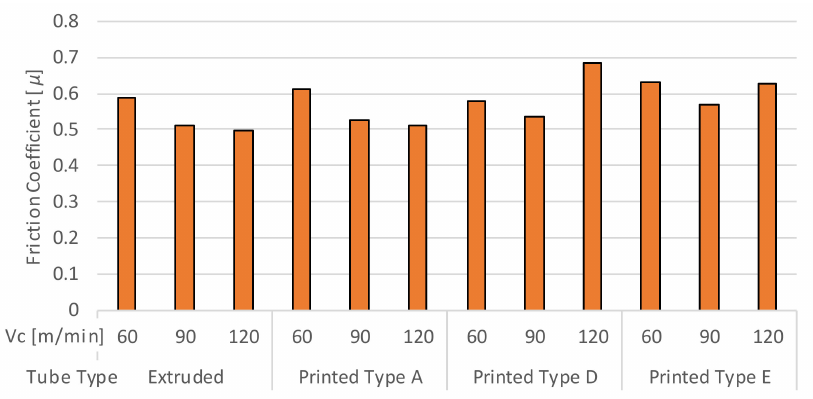
Figure 8. Mean coe ffi cient of friction for the extruded and AM tube samples.